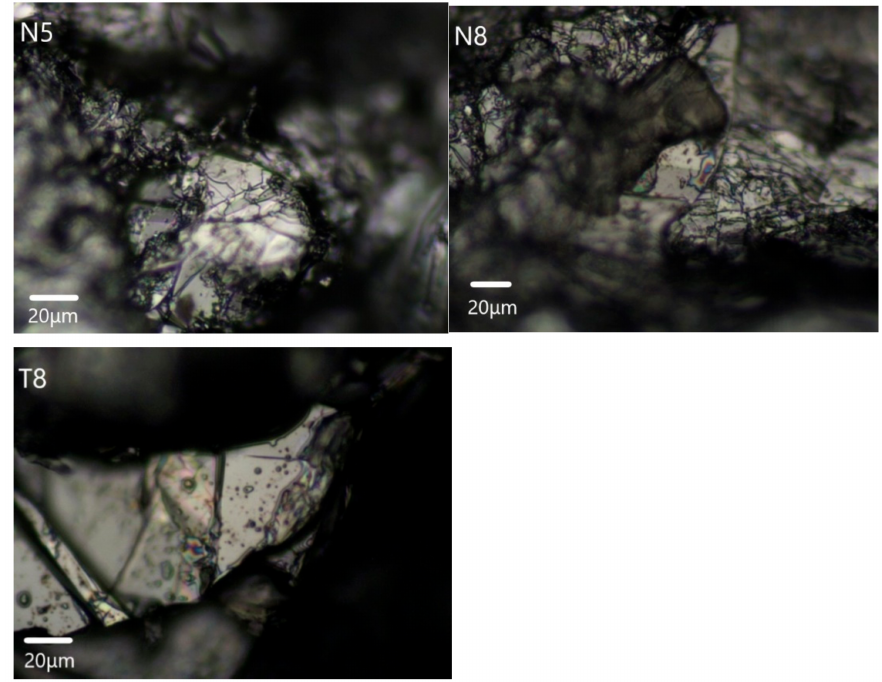
Figure 8. Location and morphology of graphite inclusions in tanzanite samples N5, N8 and